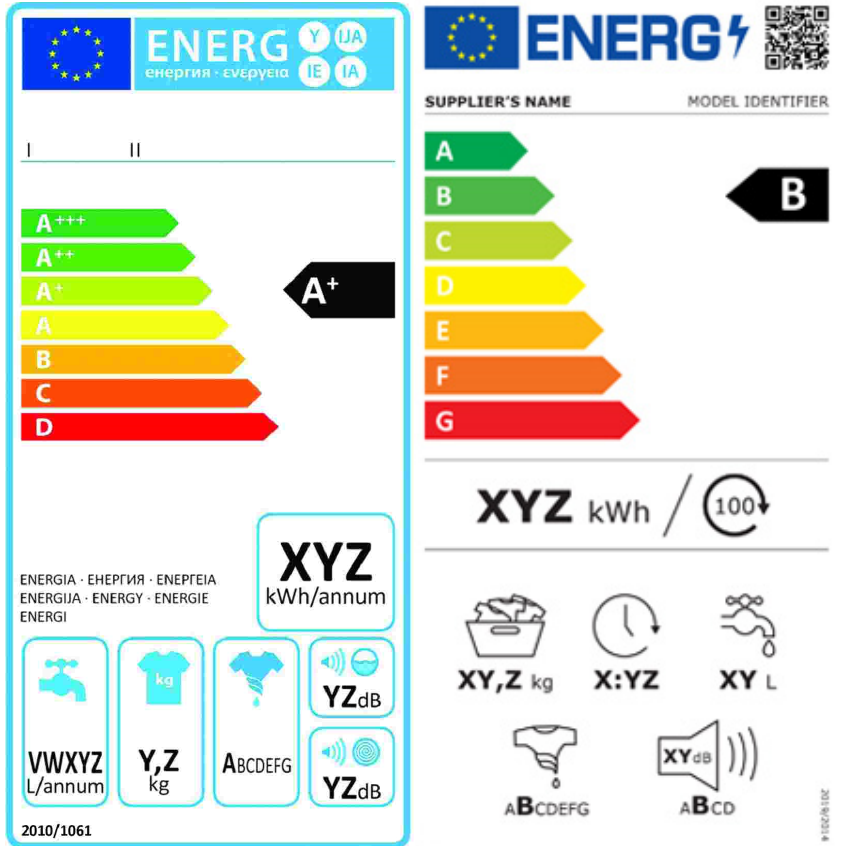
Figure 1. The old energy efficiency label (A+++–D scale) (Directive 2010/30/EU) and the new energy efficiency label (A–G scale) for washing machines, which entered into force in March 2021 (Directive 2017/1369/EU).